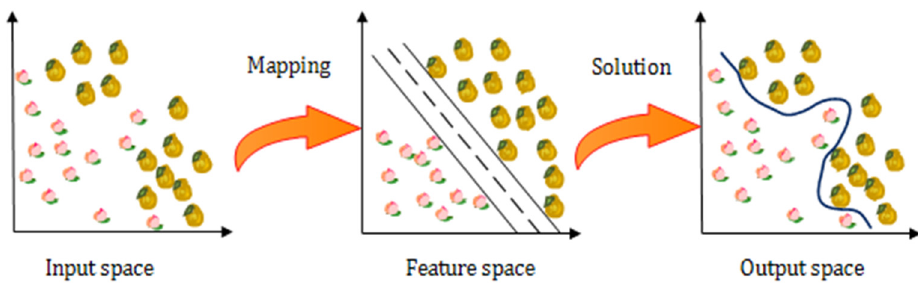
Figure 3. Schematic diagram of equivalent mapping of kernel function for nonlinear problems.